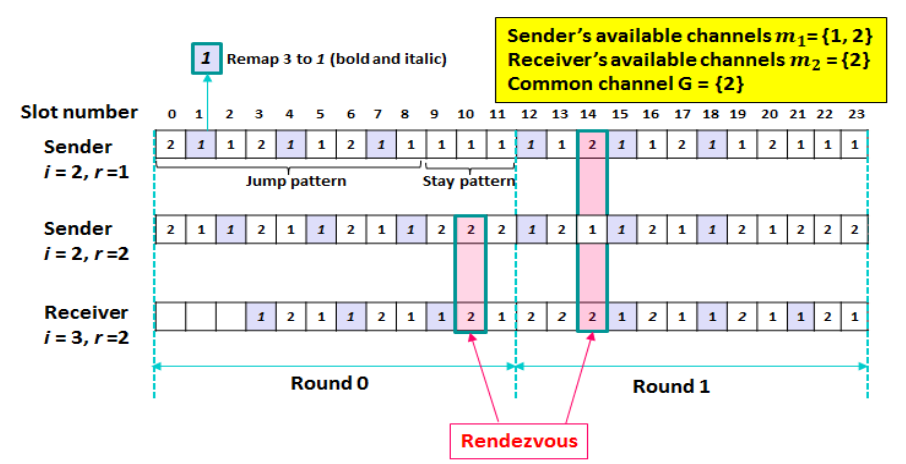
Figure 3. An example of asymmetric EJS